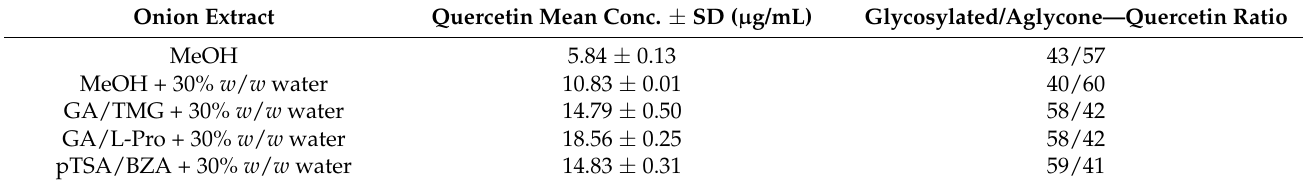
Table 1. Quantitation of quercetin amounts and glycosylated/aglycone quercetin ratio in the analyzed samples. Onion Extract Quercetin Mean Conc. ± SD ( µ g/mL) Glycosylated/Aglycone—Quercetin Ratio MeOH 5.84 ± 0.13 43/57 MeOH + 30% w / w water 10.83 ± 0.01 40/60 GA/TMG + 30% w / w water 14.79 ± 0.50 58/42 GA/L-Pro + 30% w / w water 18.56 ± 0.25 58/42 pTSA/BZA + 30% w / w water 14.83 ± 0.31